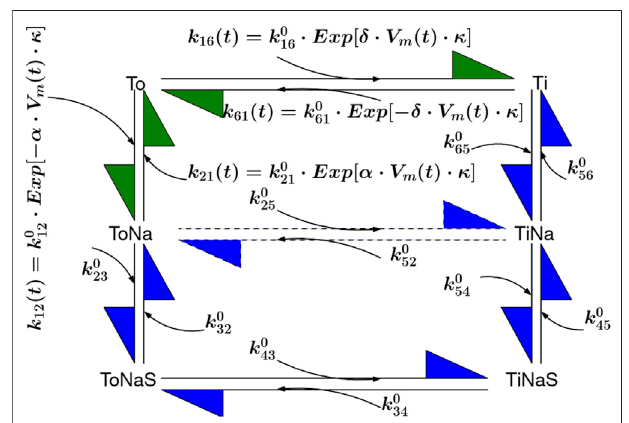
FIGURE8| SixStateModel ofSGLT1. ThetransitionsTotoTiand Toto ToNa are voltage dependent and indicated with green arrows. The reactions denoted byblue arrows arevoltage independent and described withconstant rates k 0 xy were xydescribes thereaction number in the fi gure. δ and α are phenomenological constants with 0.7 and 0.3 and κ (cid:2) F / RT , describe the fractionoftheelectrical fi eldsensedbythereaction(Parentetal.,1992;Wright et al., 2011). The rate constants are listed in Table 3